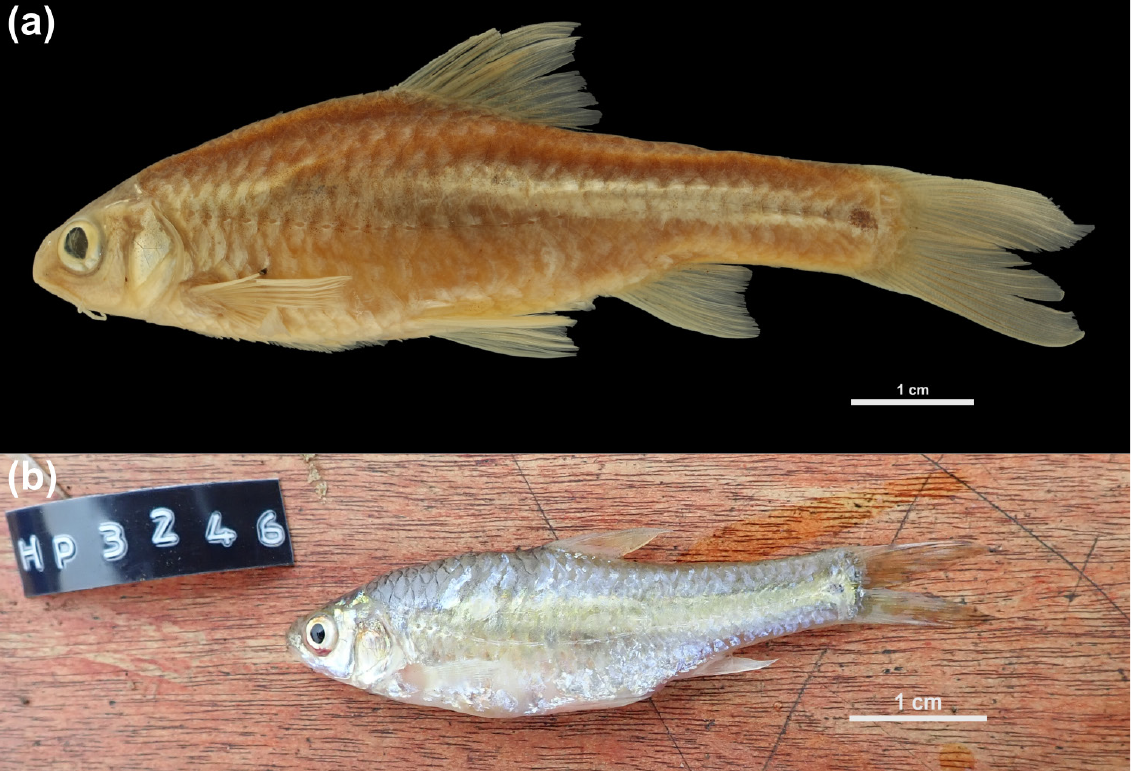
Fig. 7. (a) Lectotype of Enteromius alberti (Poll, 1939) (MRAC 64723) with 74.3 mm SL. (b) Fresh specimen of E. alberti (RMCA 2018.008.P.0248 HP 3246) with 62.4 mm